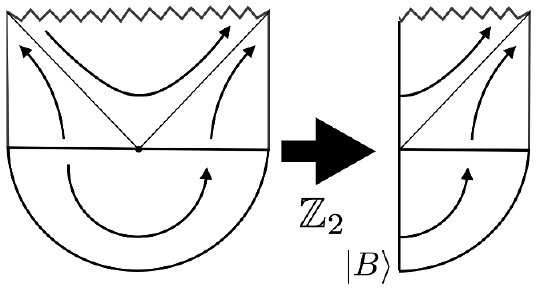
Figure 6 . Single-sided black holes can be obtained by the Z 2 identi(cid:12)cations of two sided black holes. They are dual to the boundary states evolved by (cid:12)= 4 in the Euclidean time. (cid:12) is a temperature of the black